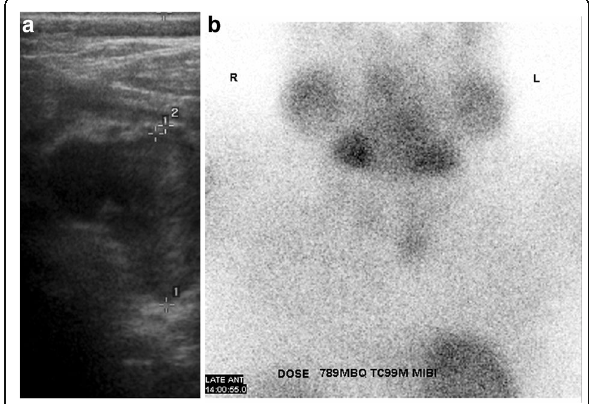
Fig. 12 a , b Ultrasound and 99m Tc-sestamibi SPECT showed a 2.5- cm left inferior parathyroid